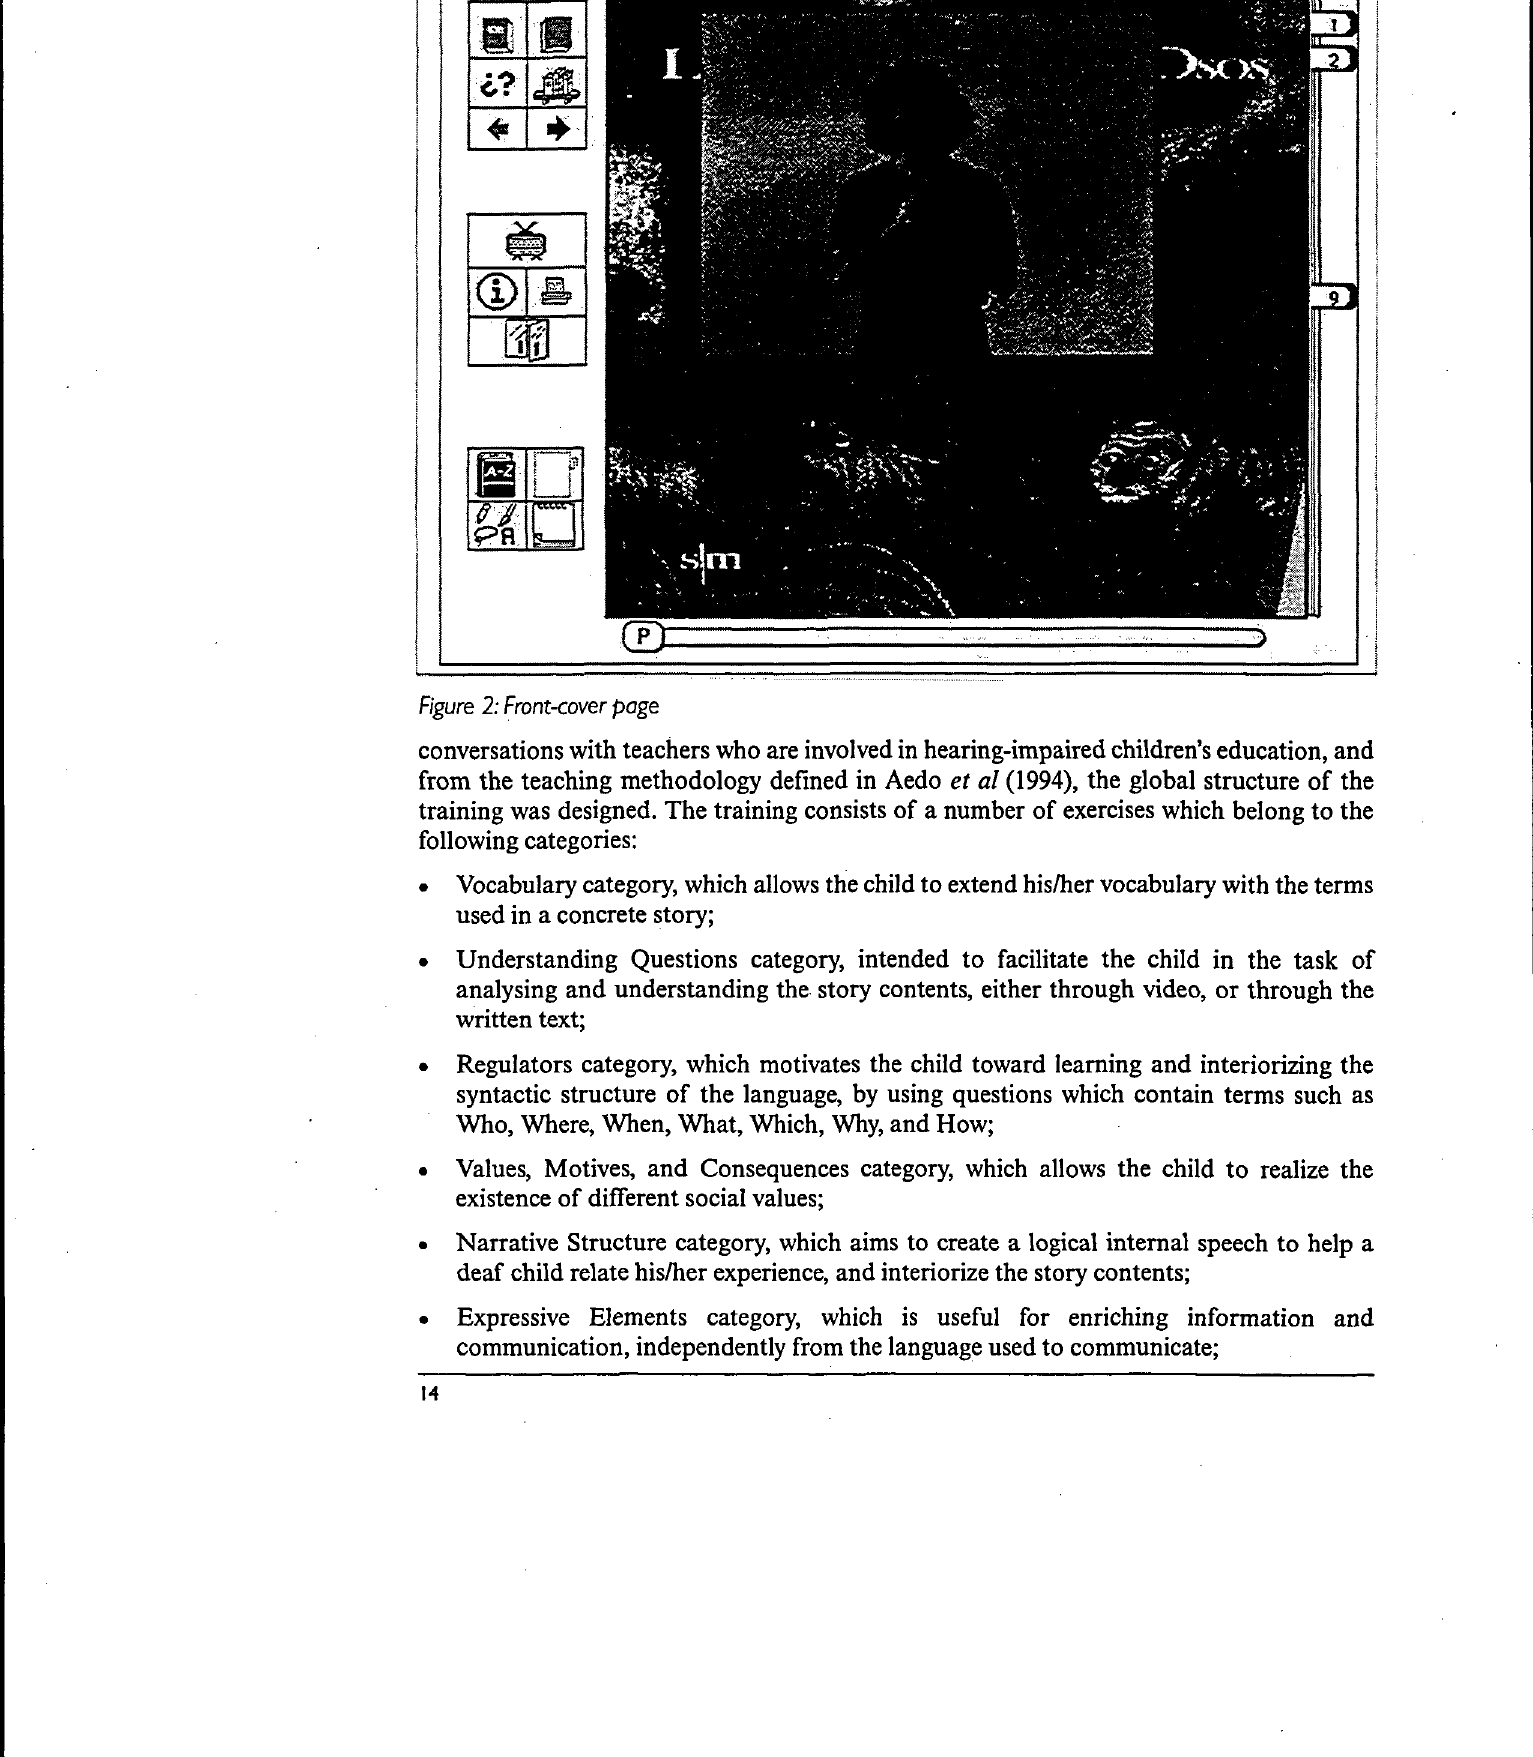
figure 2: Front-cover